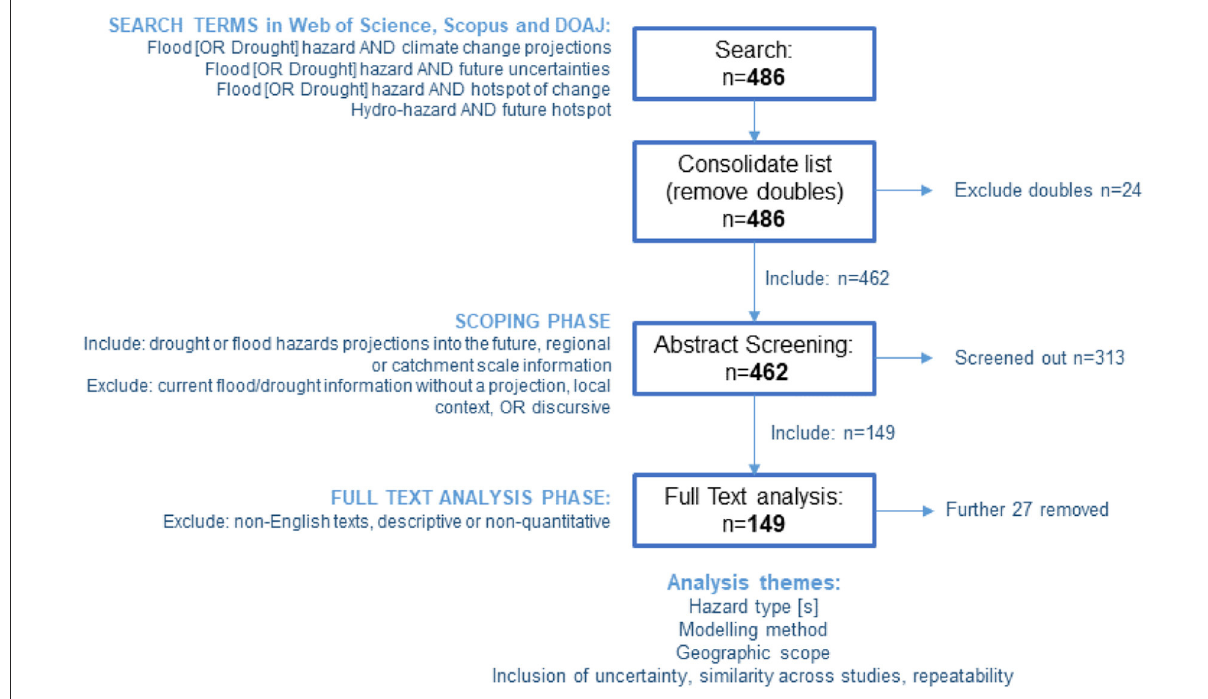
FIGURE1 Methodology for the literature